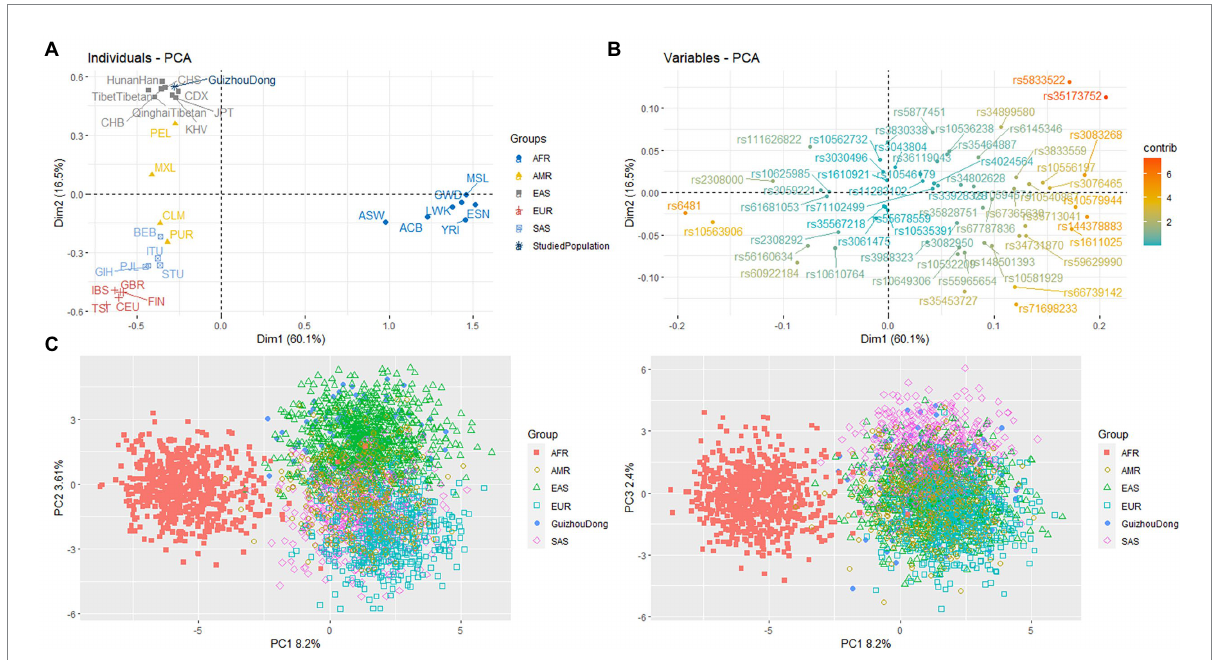
FIGURE 2 Principle component analysis of the Guizhou Dong and other compared populations. (A) Principle component analysis at population levels. (B) Contributions of each InDel locus to explaining the variability of the data set. (C) Principle component analysis at individual levels.